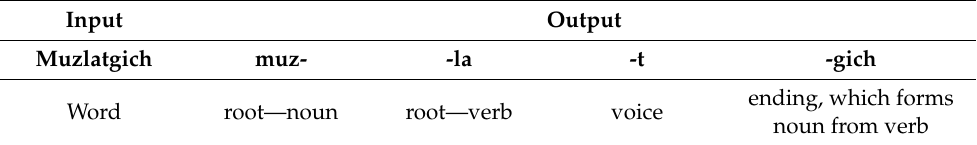
Table 11. Noun from exception word set according to grammatical morphotactics. Input Output Dadamlar Dada M lar Word root—noun possessive affix affix of plural form Table 12. Noun from exception word set according to derivative possibility. Input Output